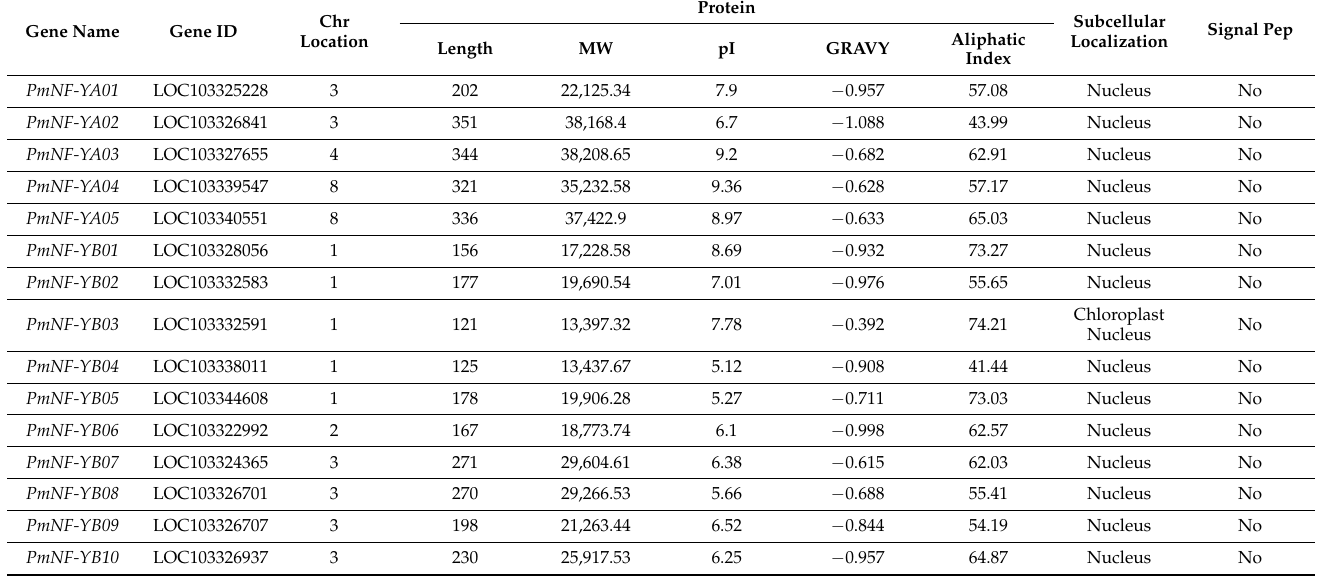
Identification and physicochemical properties of the NF-Y gene family in the Prunus mume